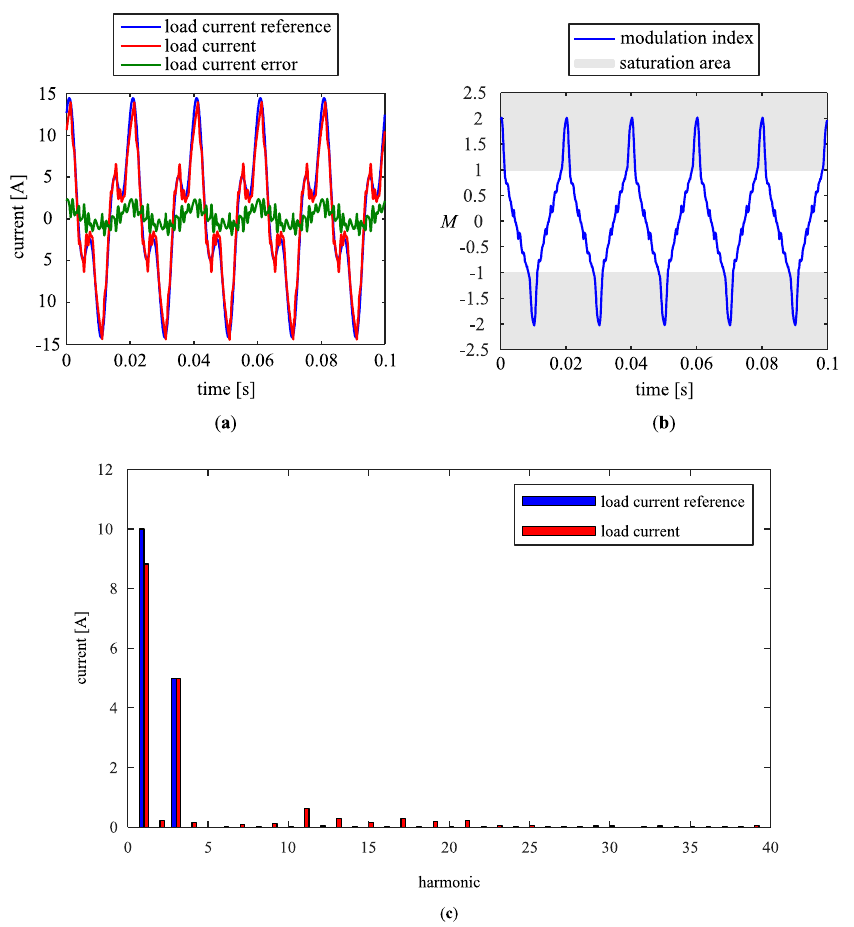
Figure 9. Power converter operating above the saturation level V S max ; ( a ) Load current reference i* (containing fundamental harmonic with amplitude of 10 A and the third harmonic with amplitude of 5 A), load current i and load current error ε ; ( b ) modulation index M; ( c ) frequency spectra of load current reference i* and load current i .